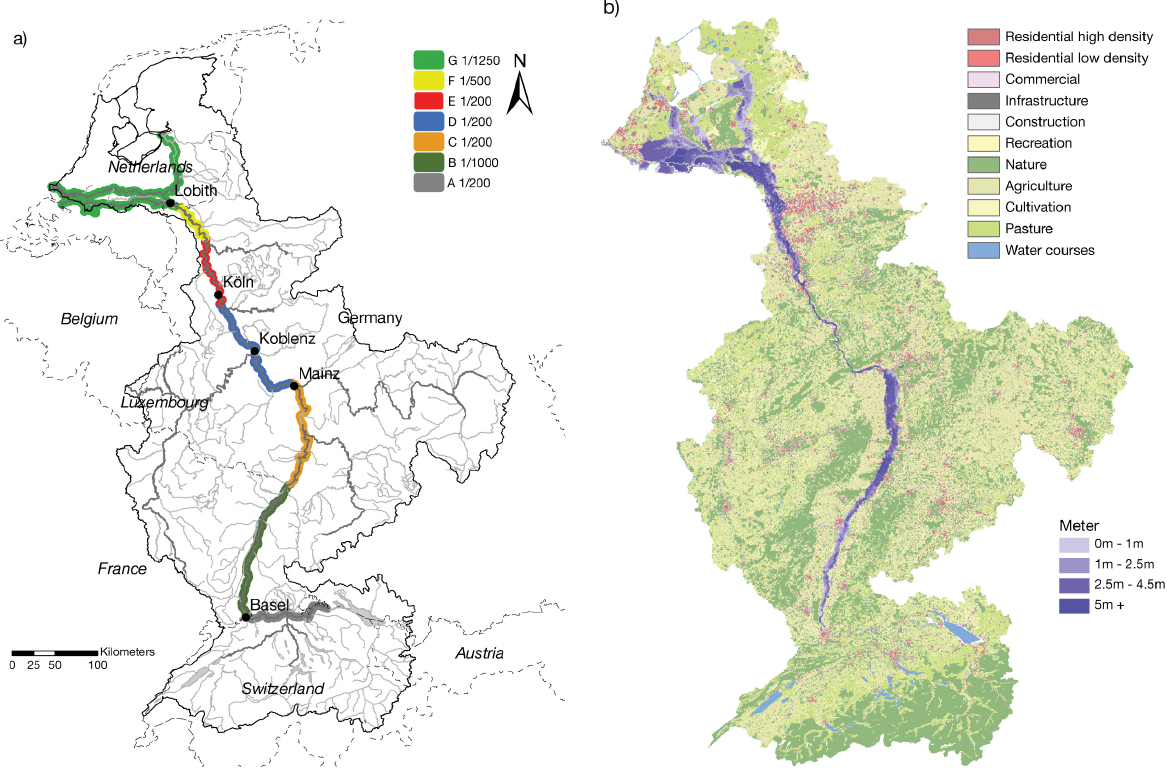
Fig. 1. Maps of the Rhine basin: (a) (estimated) safety levels and (b) land use in the reference situation. Figure (b) also shows the potential inundated area due to fluvial flooding from the